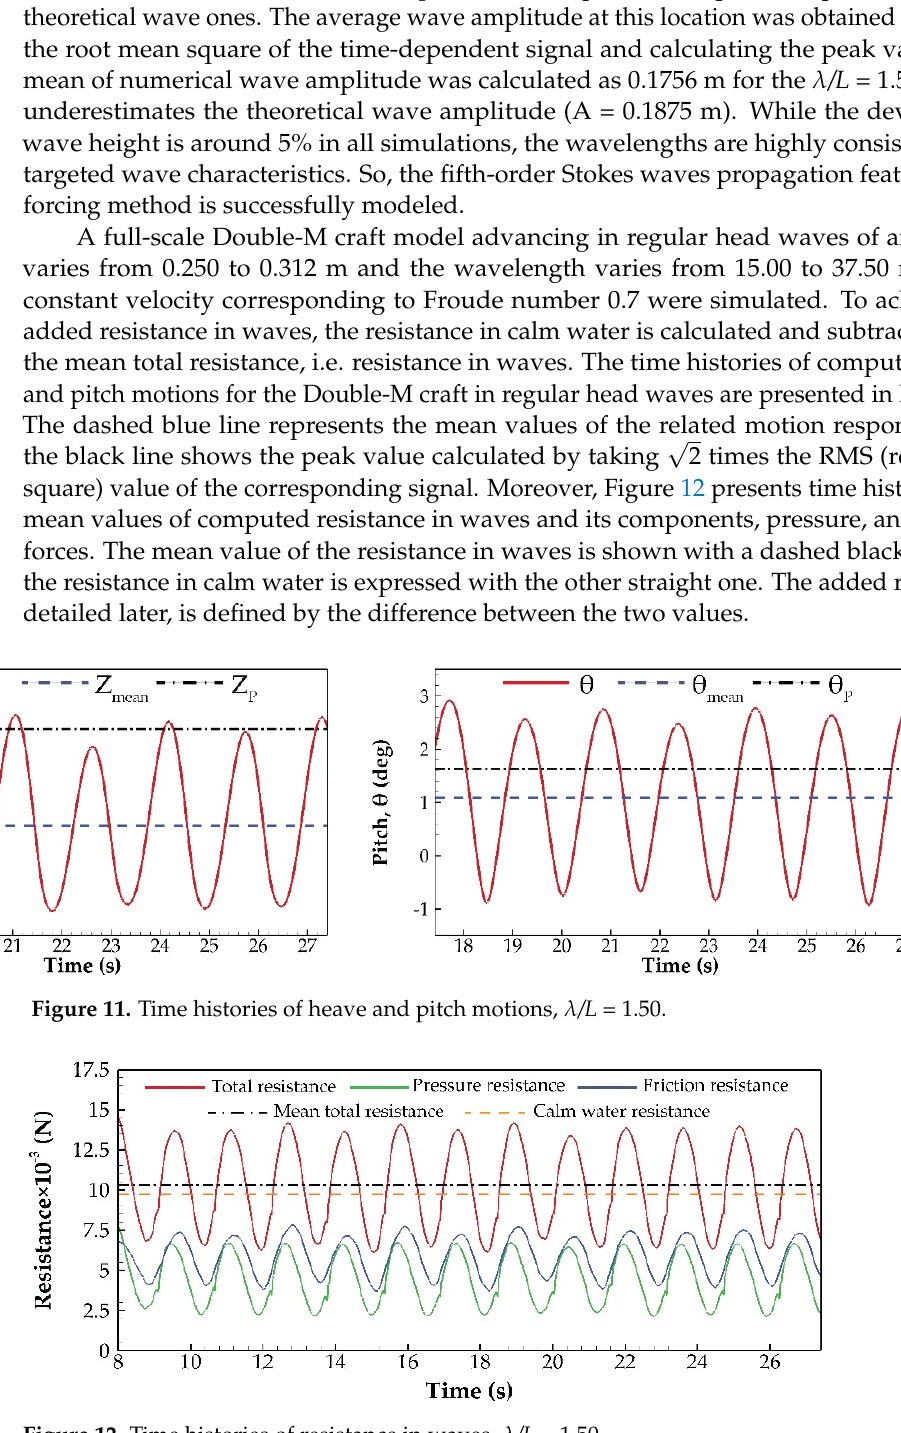
Figure 12. Time histories of resistance in waves, λ /L = 1.50.